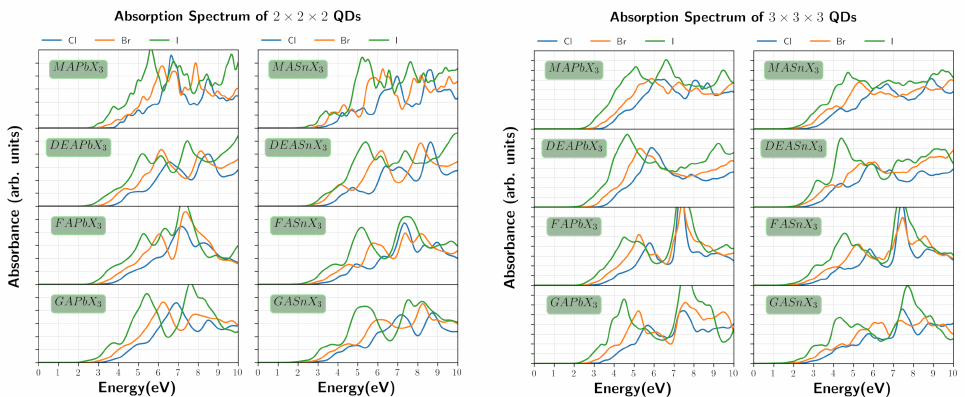
Figure 4. Dependence of the absorption spectra on X anion type for NPs with sizes 2 × 2 × 2 and 3 × 3 × 3.